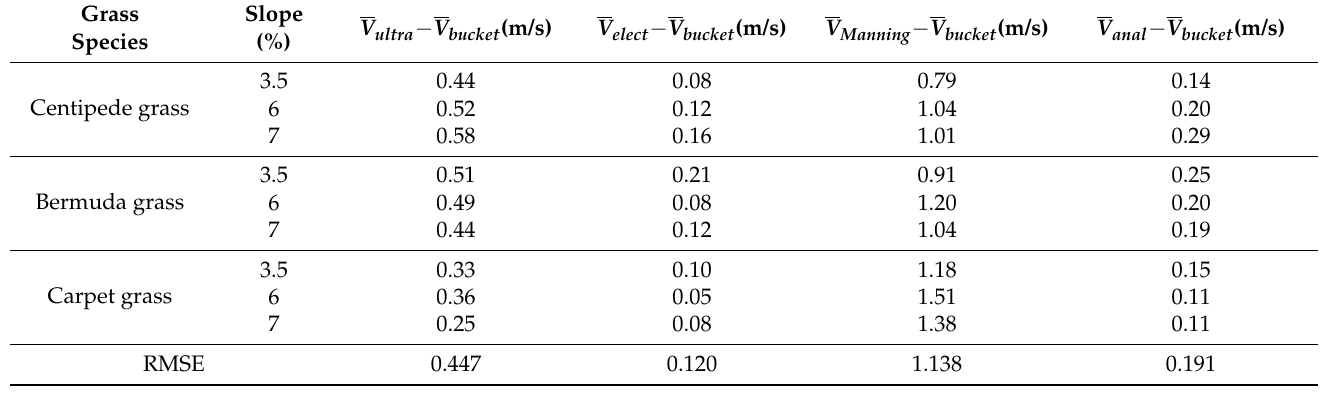
Table 2. Differences in the average velocities obtained from the different methods comparing with the bucket method.